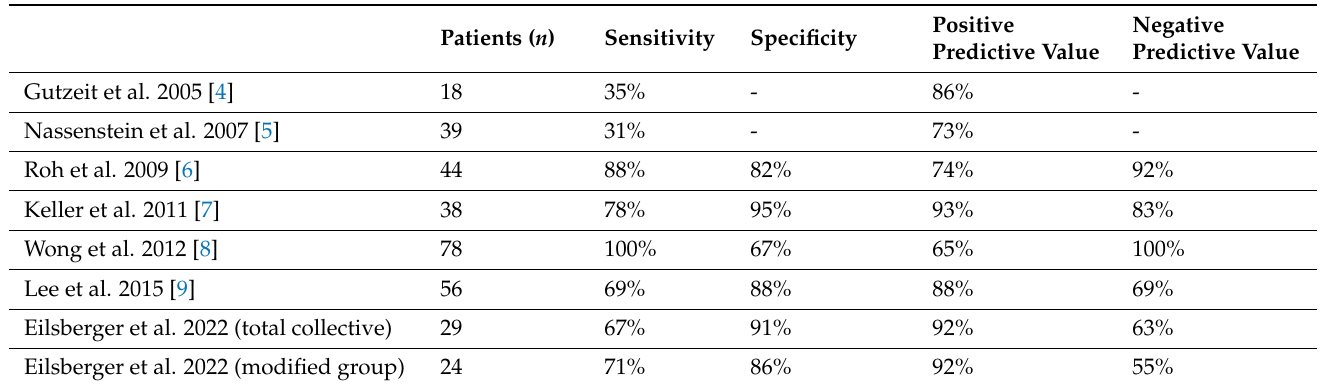
Table 5. Overview of various